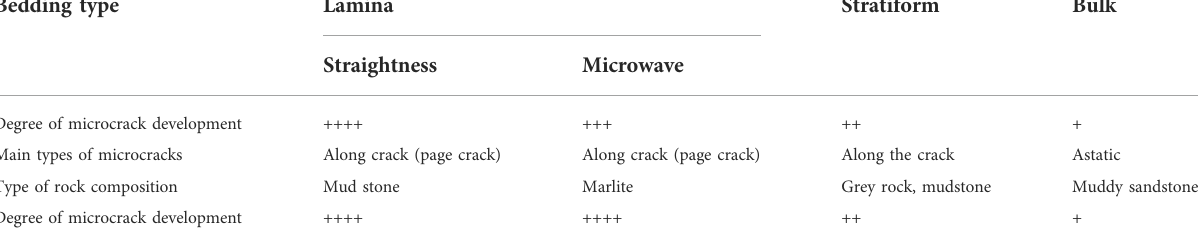
TABLE 1 Statistical table of crack in fl uencing factors. Bedding